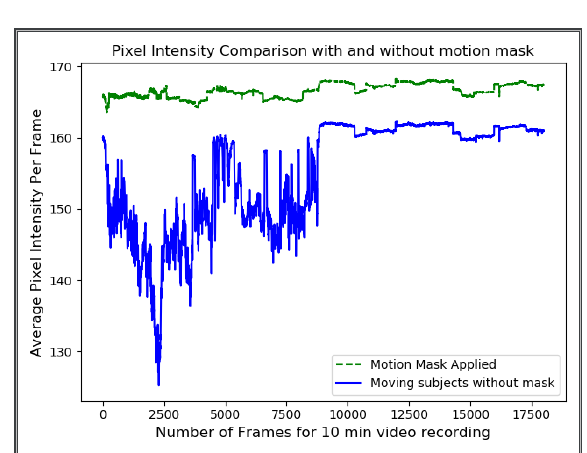
Figure 5. Comparing pixel fluctuations caused by a